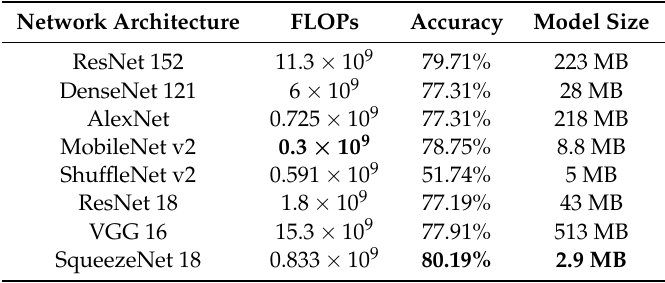
Figure 8. Spectrograms of the ten types of sounds of the UrbanSound8K dataset. Table 2. Number of FLOPs, model size and accuracy on the testing fold for different network